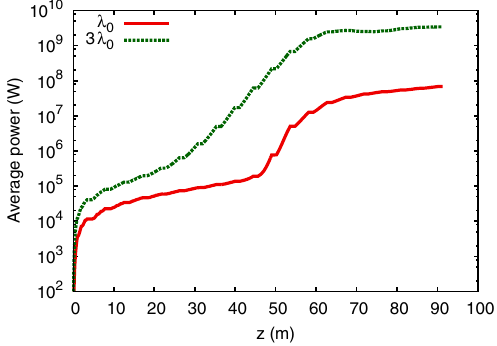
FIG. 11. Average power produced at a fundamental of 0.9 nm and at the (nonlinear) third harmonic for a SASE beam